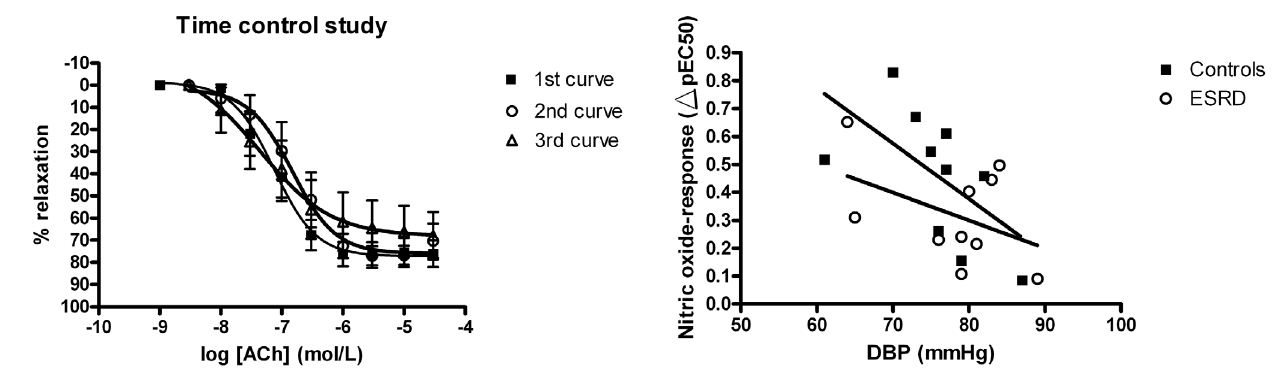
Figure 3. Time control experiments; three consecutive concen- tration response curves, with 20 minutes of rest in between, without use of blocker.